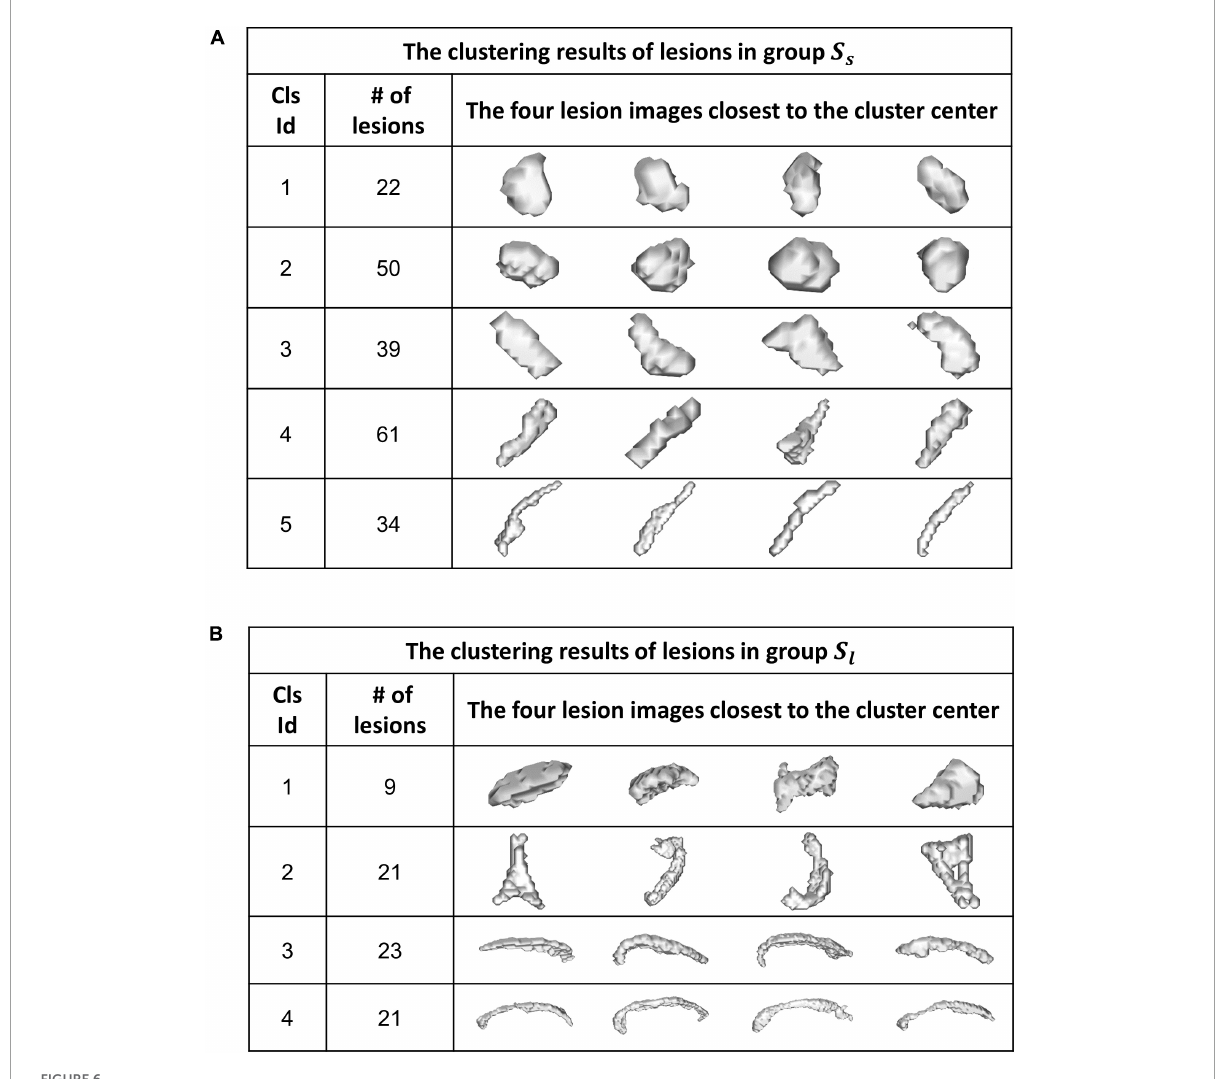
FIGURE6 A K-means algorithm was performed to categorize WMH3D lesion shapes to different clusters for Group S s (A) and Group S l (B)